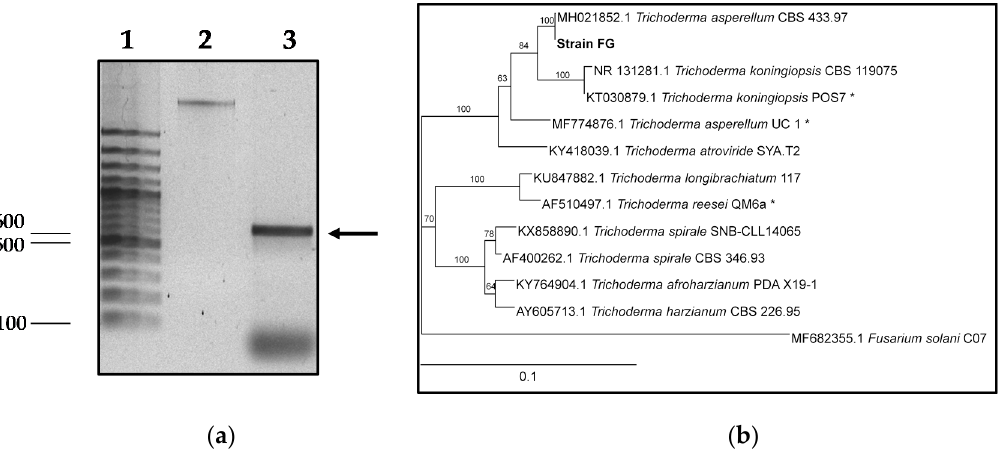
Molecular analysis of strain FG. ( a ) Gel electrophoresis of strain FG DNA. Lane 1: Molecular marker 100 bp; lane 2: genomic DNA from strain FG extracted with the hexadecyltrimethylammonium bromide (CTAB) method; lane 3: PCR product using ITS primers and genomic DNA as a template. Arrow indicates the PCR product of the expected size (~570 bp); ( b ) Neighbor-joining analysis with the Kimura-2-parameter model after aligning ITS1-5.8-ITS2 sequences with Clustal X in MEGA7. Bootstrap analyses were performed for 10,000 replicates. The ITS1-5.8-ITS2 sequence from Fusarium solani was used as outgroup. Asterisk indicates fungal strains characterized as high cellulases producers [18,34,35,36,37,38] .